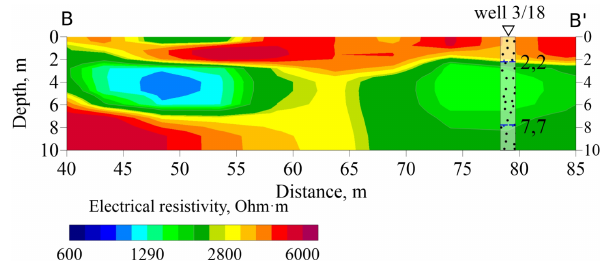
Figure 10. Two-dimensional electrical resistivity as results of the ERT inversion. Displayed is the part from profile meter 40 to 85 of the bigger section in Fig. 5 that corresponds to the section of the HFIP inversion in Fig. 9 (B to B (cid:48) ). Additionally, the location of well 3/18 and its estimated boundaries from permafrost to the unfrozen layer are